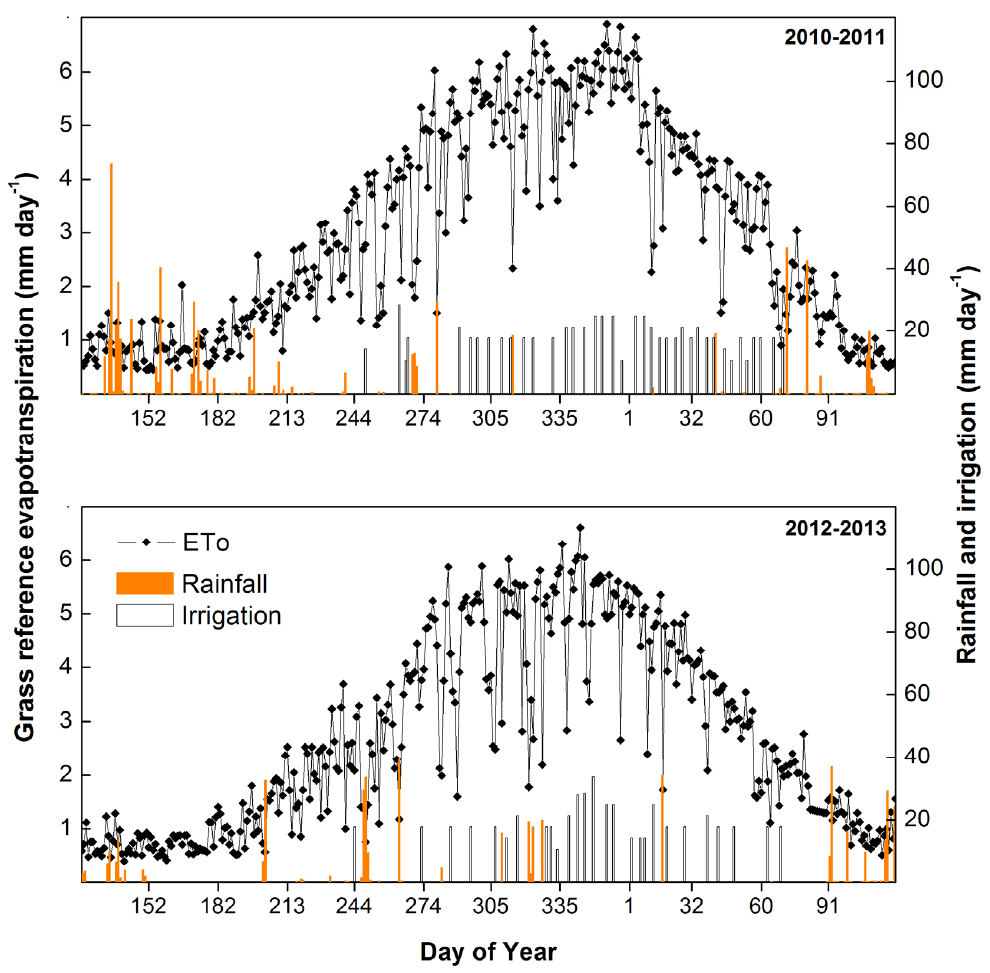
Figure 2. Daily reference evapotranspiration (FAO-56 Penman–Monteith ET o ), rainfall and irrigation during the 2010–2011 and 2012–2013 growing seasons.